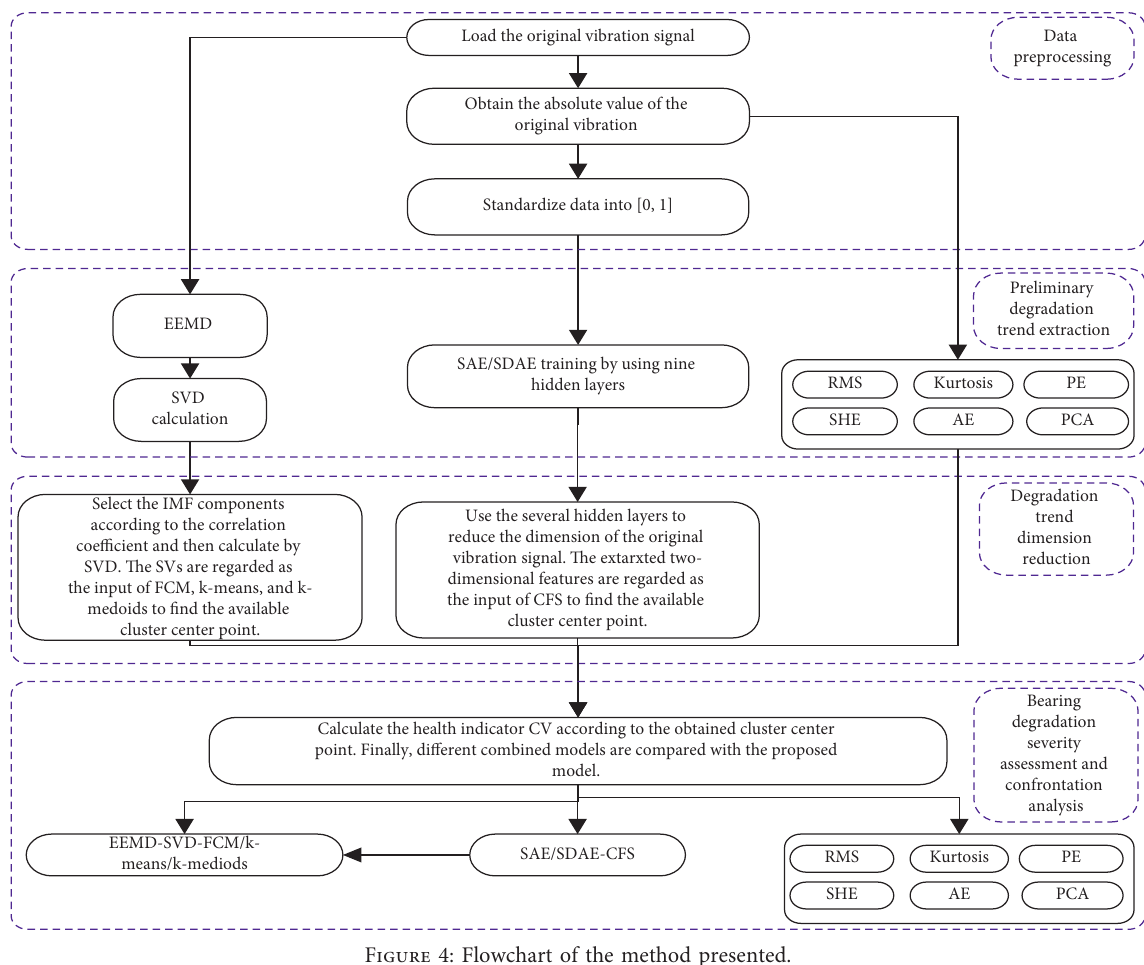
Figure 4: Flowchart of the method presented.